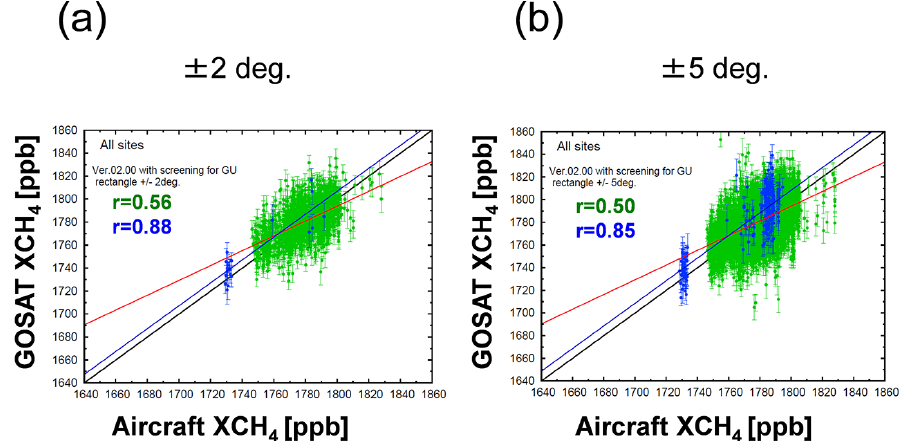
Figure 11. Scatter diagrams between GOSAT XCH 4 observed within (a) ± 2 ◦ and (b) ± 5 ◦ latitude–longitude boxes centered at each aircraft observation site and aircraft-based XCH 4 obtained by curve fitting at all sites. Green and blue dots indicate XCH 4 obtained over land and ocean regions, respectively. Red and blue lines denote the regression lines, statistically significant at the 99% level, over land and ocean regions, respectively. The black lines show one-to-one correspondence.